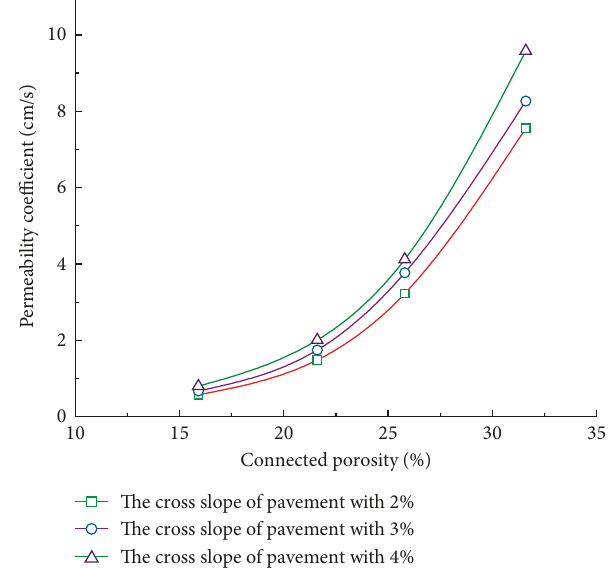
Figure 10: Test results of drainage performance.